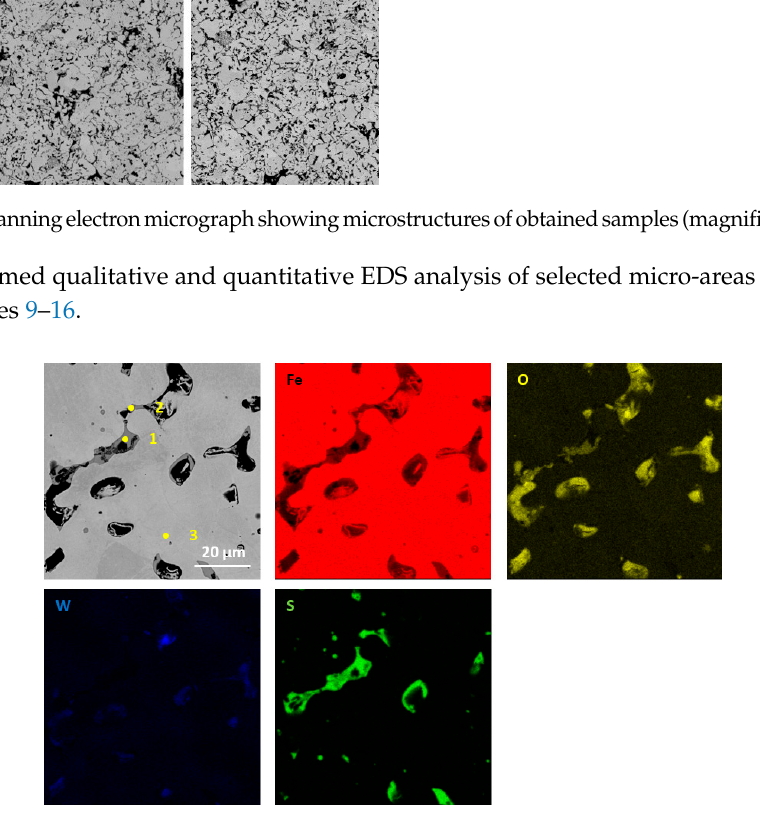
Figure 10. EDS mapping of sintered Fe with the addition of WS 2 with a size of 0.6 μ m (for pressing pressure 250 MPa). Table 5. EDS point analysis of a sintered Fe sample (for pressing pressure 350 MPa) containing 2.5% WS 2 with a grain size of 0.6 μ m. Point Fe at.% (wt.%) O at.% (wt.%) W at.% (wt.%) S at.% (wt.%) 1